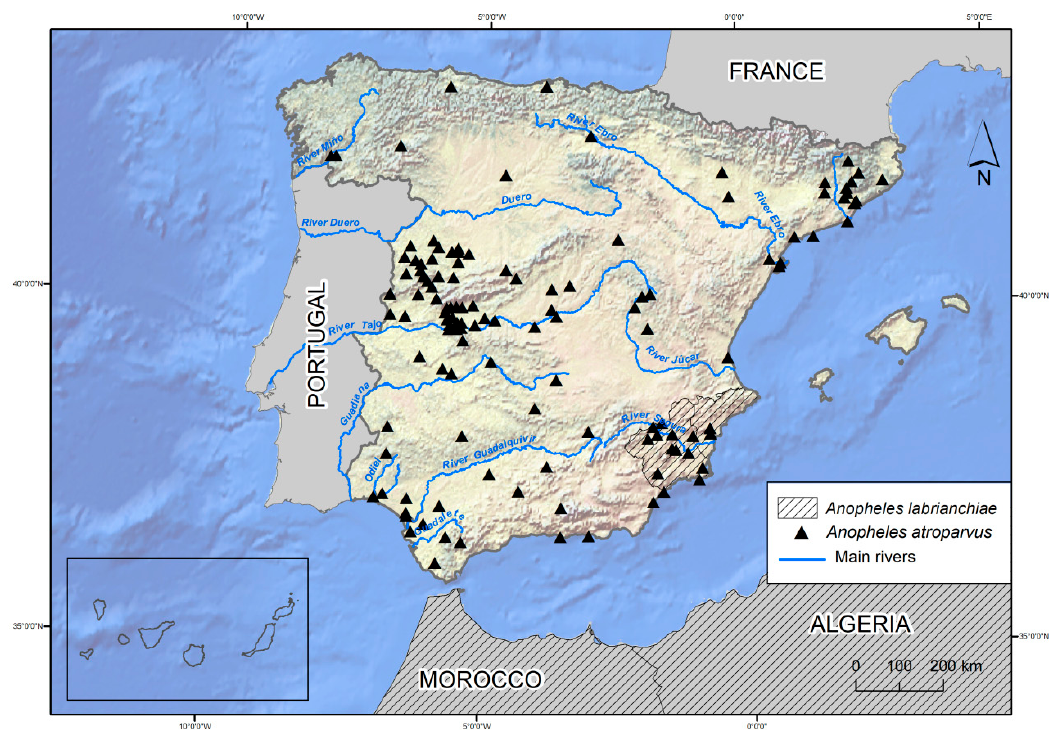
Figure 7. Distribution of localities where the presence of Anopheles atroparvus and Anopheles labranchiae was recorded, represented by black triangles and cross-hatched areas, respectively (elaborated from [36,38–40]).